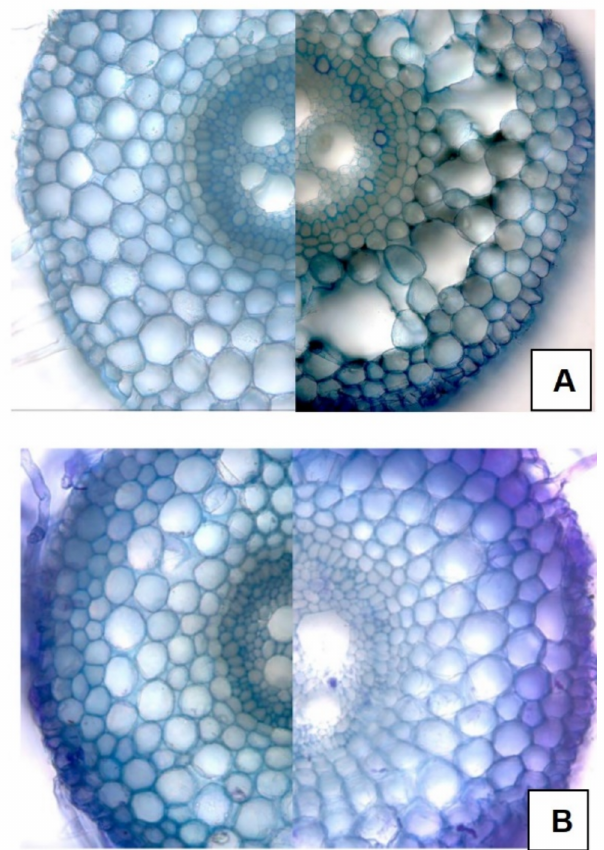
Figure 1. Light micrographs of cross sections of adventitious roots of barley waterlogging tolerant genotype Deder 2 ( A ) and waterlogging sensitive genotype Naso Nijo ( B ); no waterlogging treatment (left half) and after 3 days of waterlogging treatment (right half). Images taken from De Castro